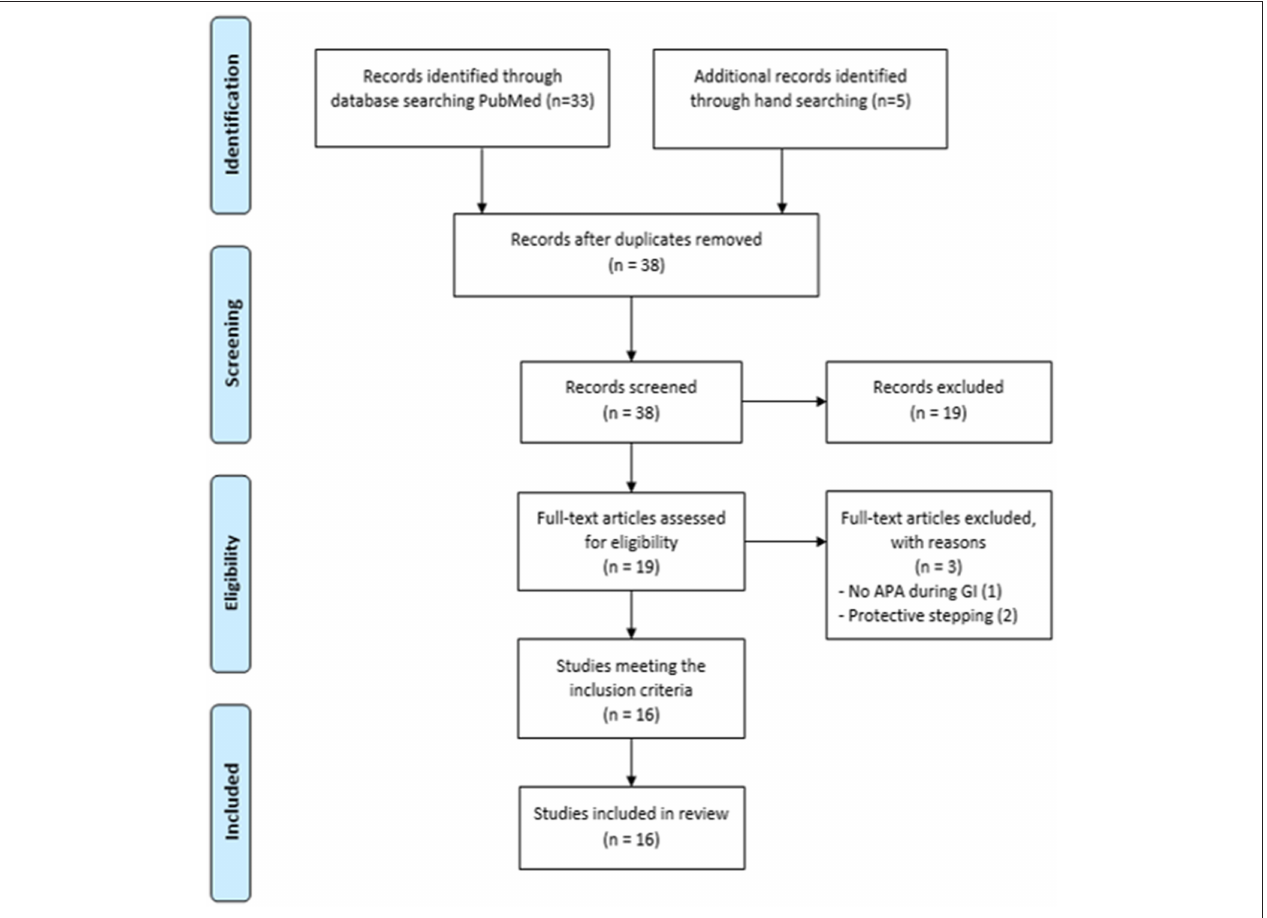
FIGURE 2 | Study selection procedures and results reported in a flow-chart, as suggested by Moher et al. (15) and according to CONSORT